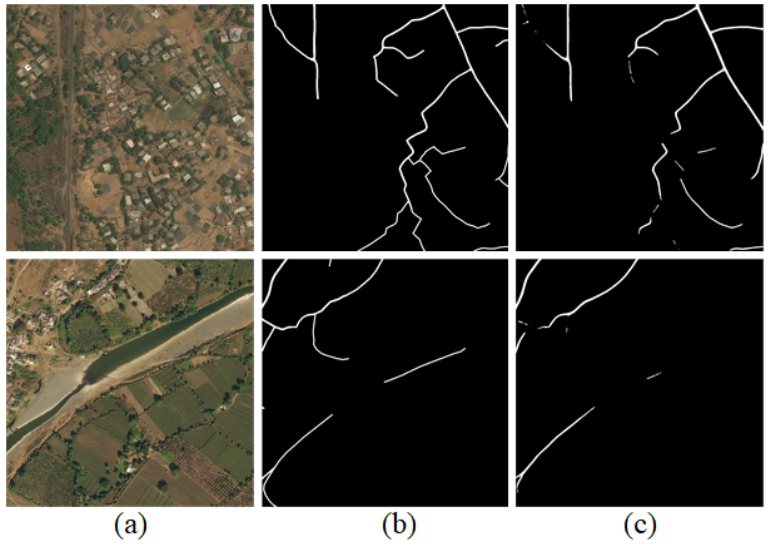
Figure 10. Two examples that our MSPNet fails. ( a ) Test image. ( b ) Ground Truth. ( c ) Segmentation results of our